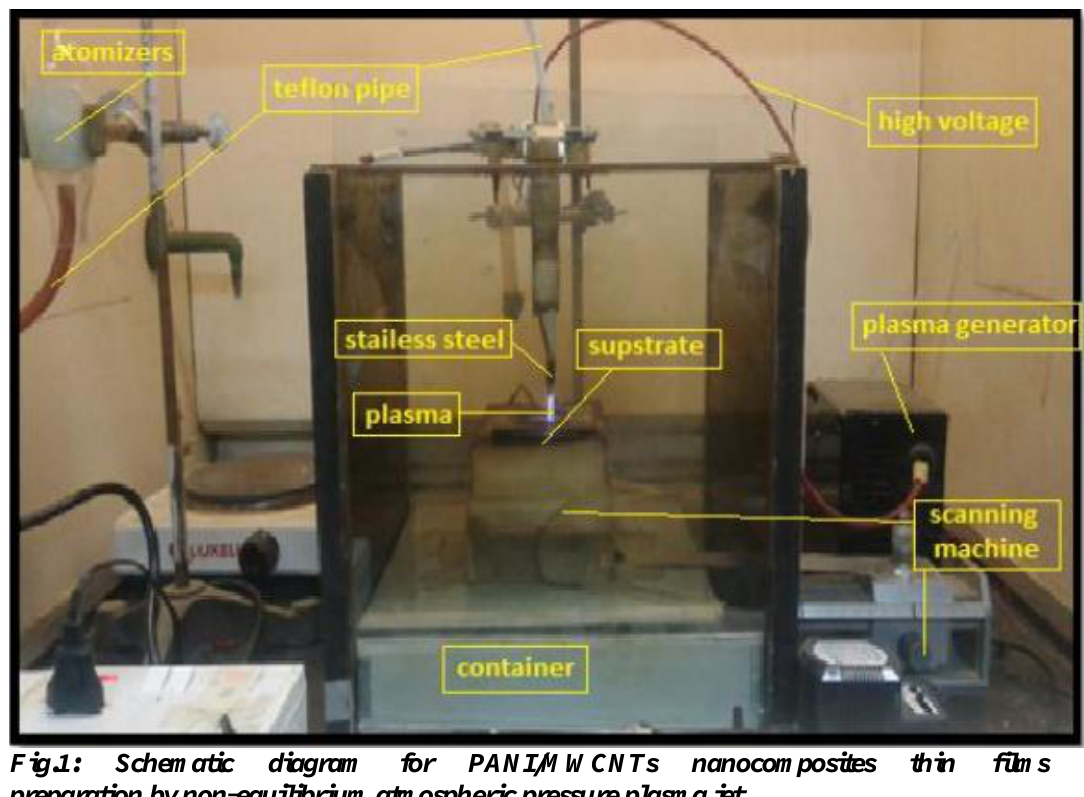
Fig.1: Schematic diagram for PANI/MWCNTs nanocomposites thin films preparation by non-equilibrium atmospheric pressure plasma jet.